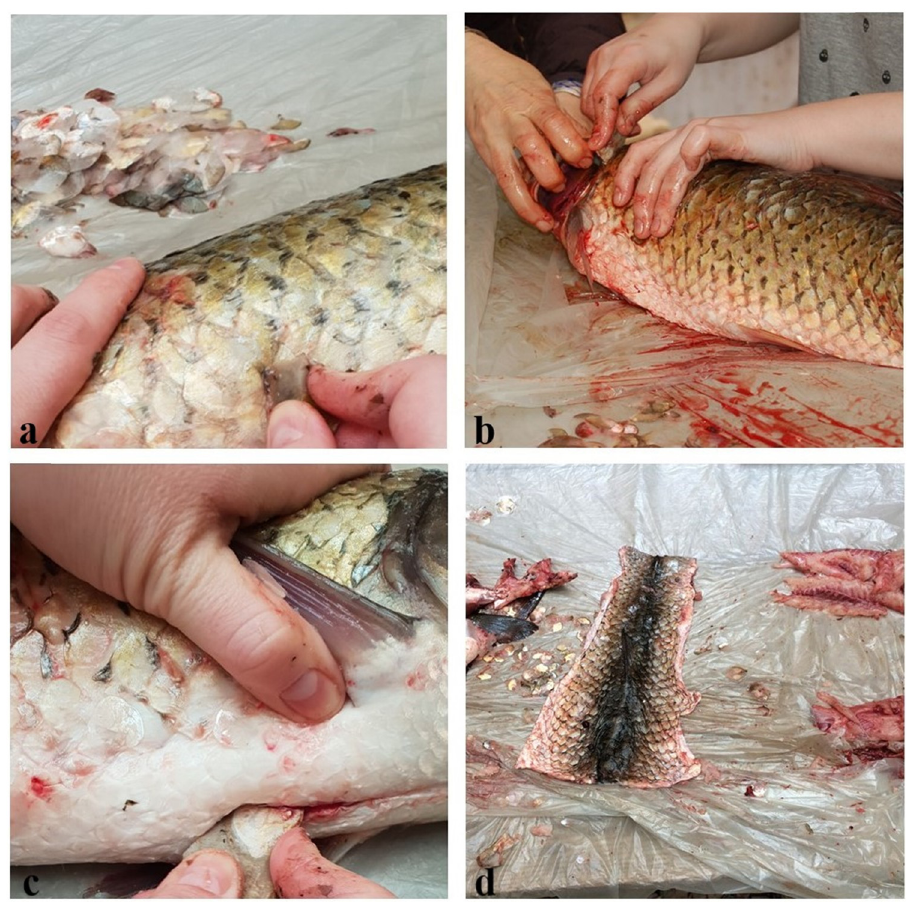
Figure 2: ( a ) Scaling, ( b ) decapitation, ( c ) splitting the fi sh open before gutting, and ( d ) the removal of skin, organs, and fi lleting ( photo A. Petrovi ć and A. Vinet )